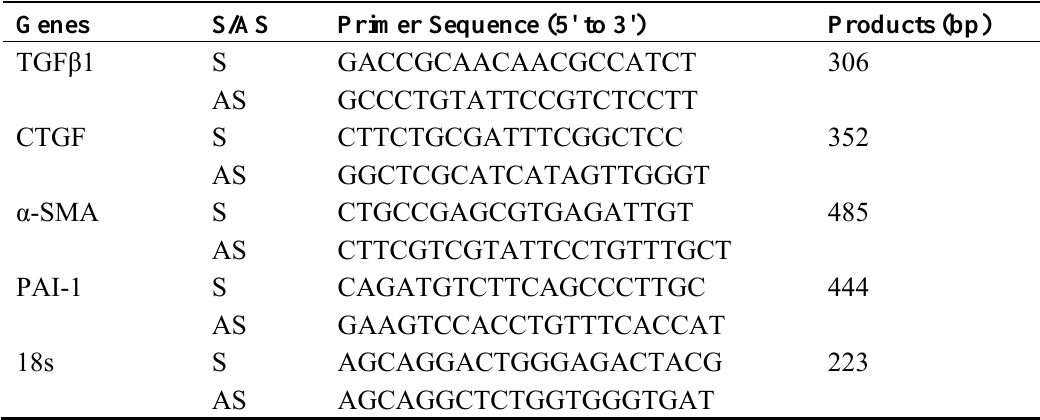
Table 1. RT-PCR primers and